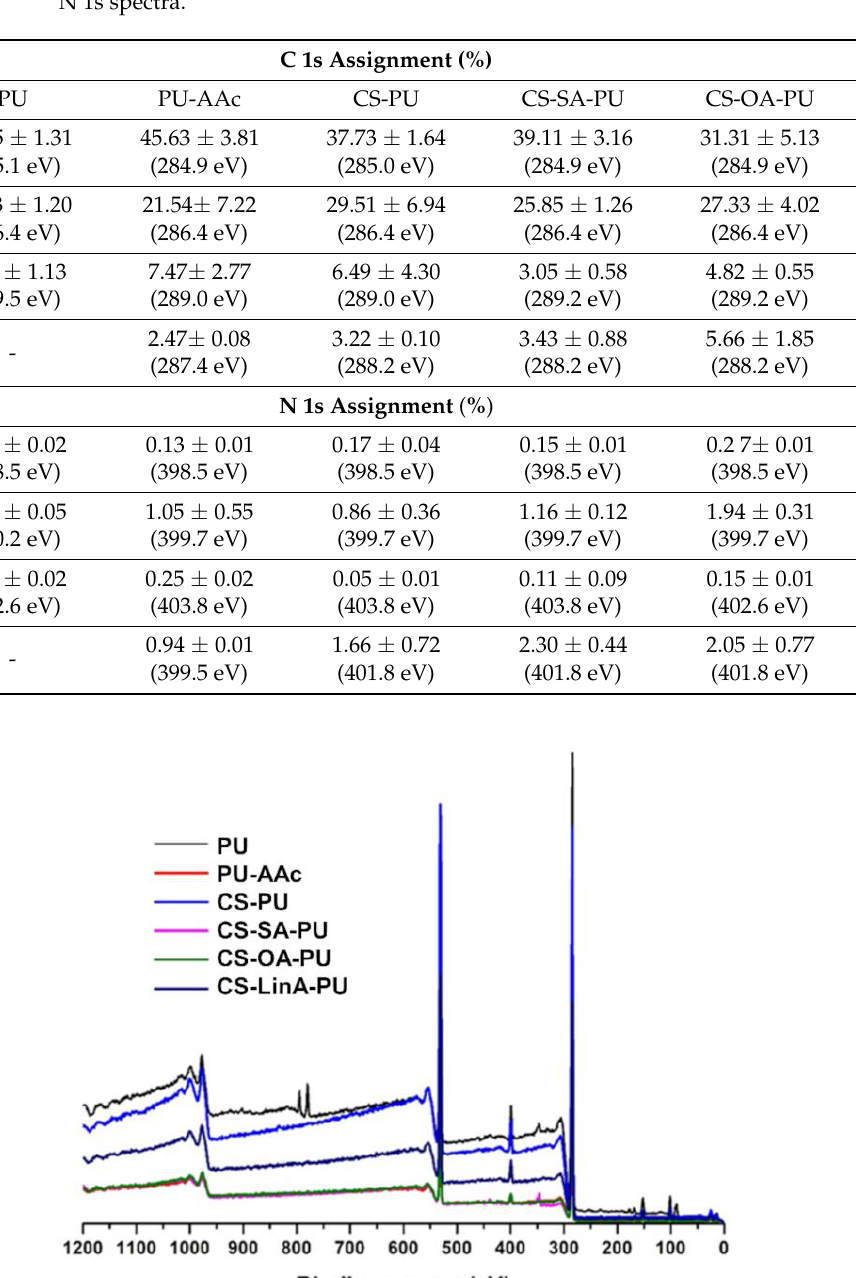
Table 1. Percentage contributions of distinctive chemical bonds in the high-resolution C 1s and N 1s spectra.